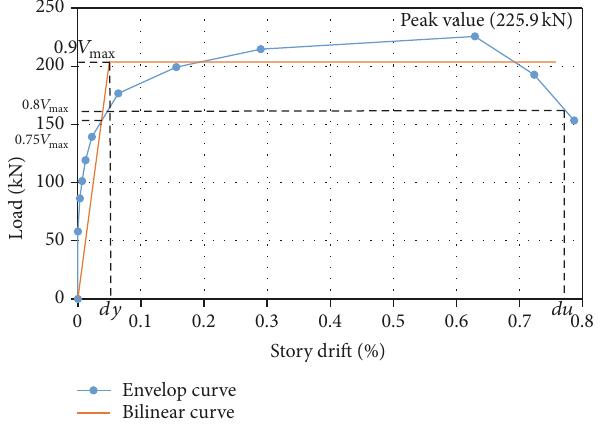
Figure 15: Bilinear curve of CBM building.